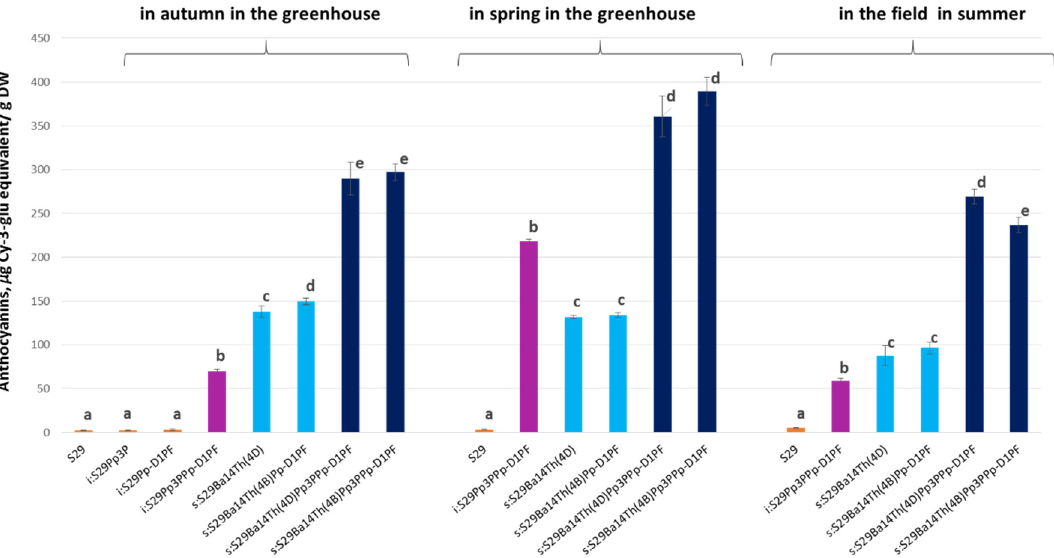
Figure 4. The total anthocyanin content (TAC) of methanol extracts from whole-grain (WG) flour of wheat plants grown in a greenhouse in the autumn and springtime or in the field in the summer.